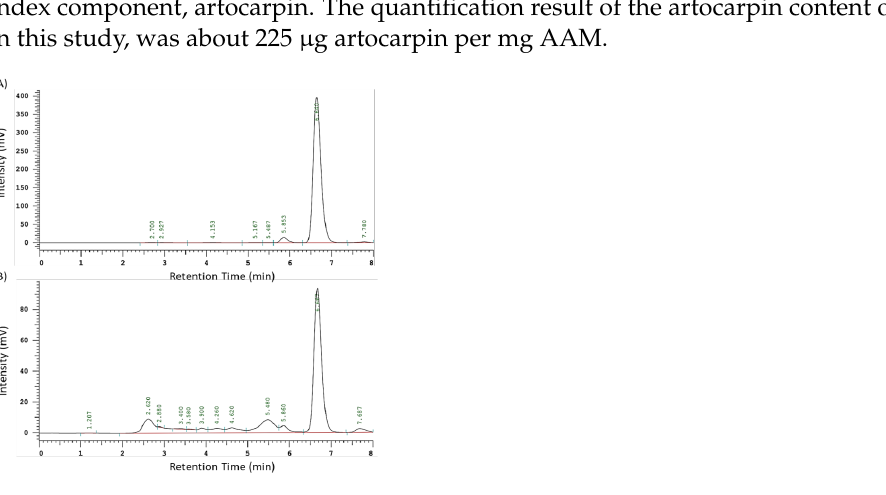
Figure 1. HPLC chromatography of ( A ) artocarpin at 100 µg/mL and ( B ) AAM at 100